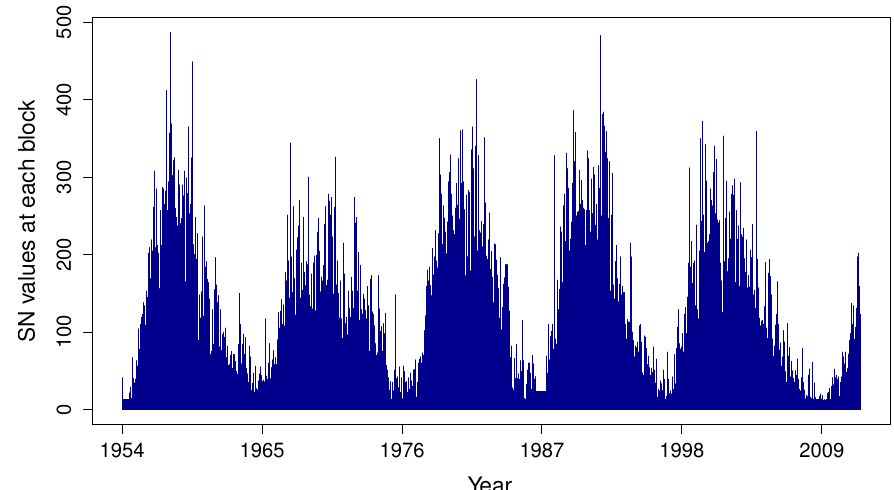
Figure 1. Daily values of the SN for the period of January 1954 to December 2011 are from the Purple Mountain Observatory.